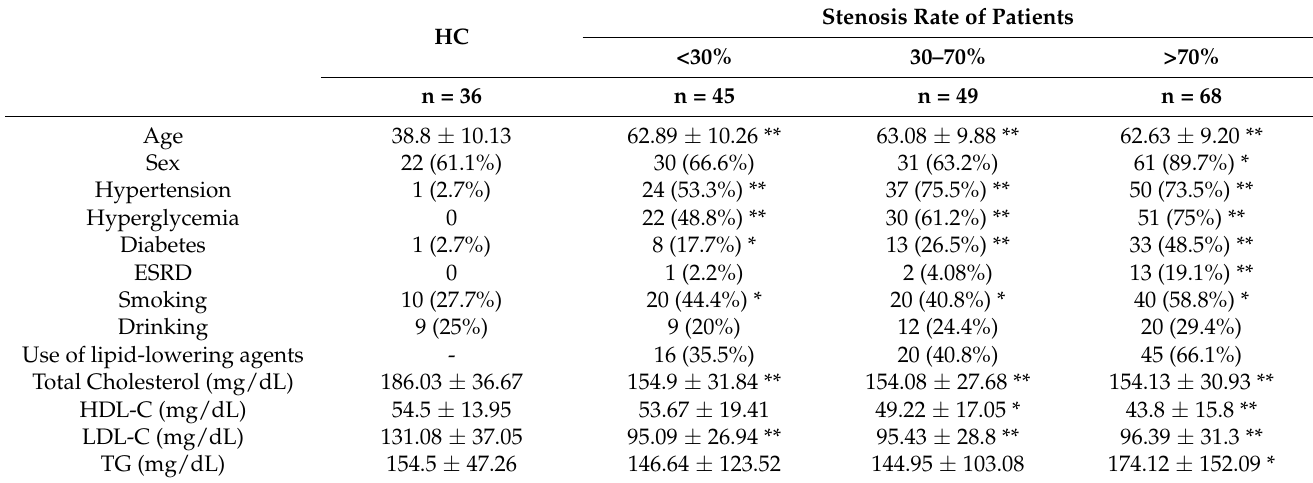
Table 1. Comparison of clinical characteristics and lipid profile between HC and patients with